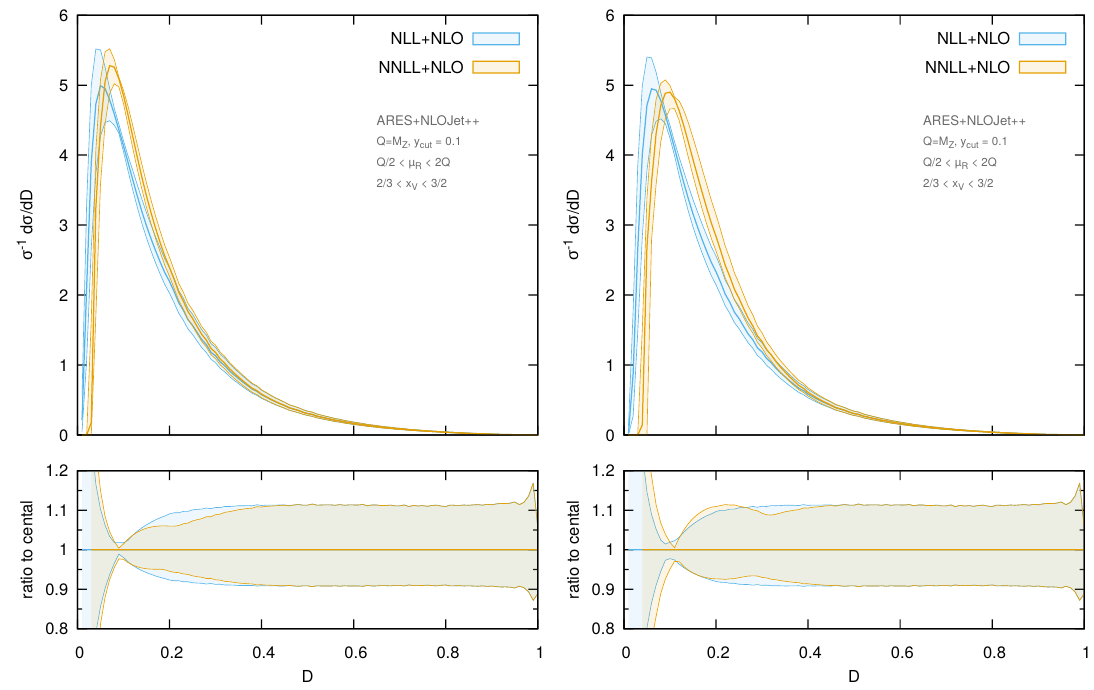
Figure 4 . The matched distribution for y cut = 0 : 1 and Q = M Z . The left plot using the X const scheme and the right using the X prod